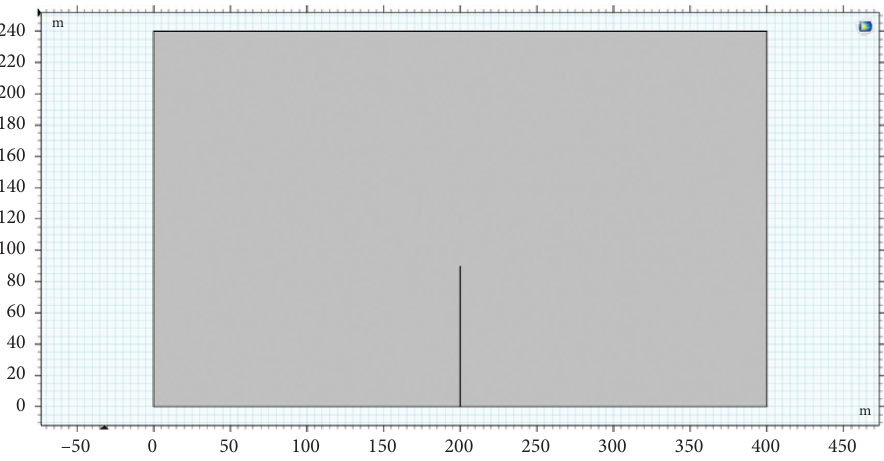
Figure 10: 90m drilling geometry